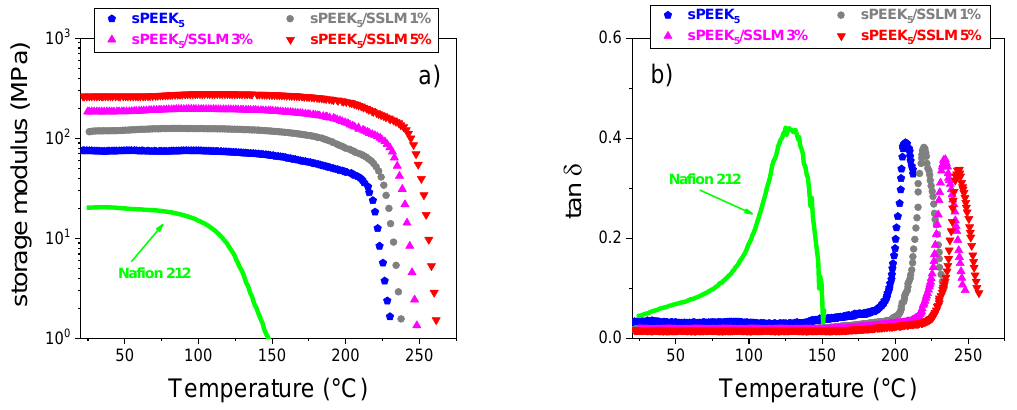
Figure 8. Storage modulus E’ versus T ( a ) and tan δ versus T ( b ) of sPEEK membranes at different filler content. Nafion 212 is also reported for comparison.